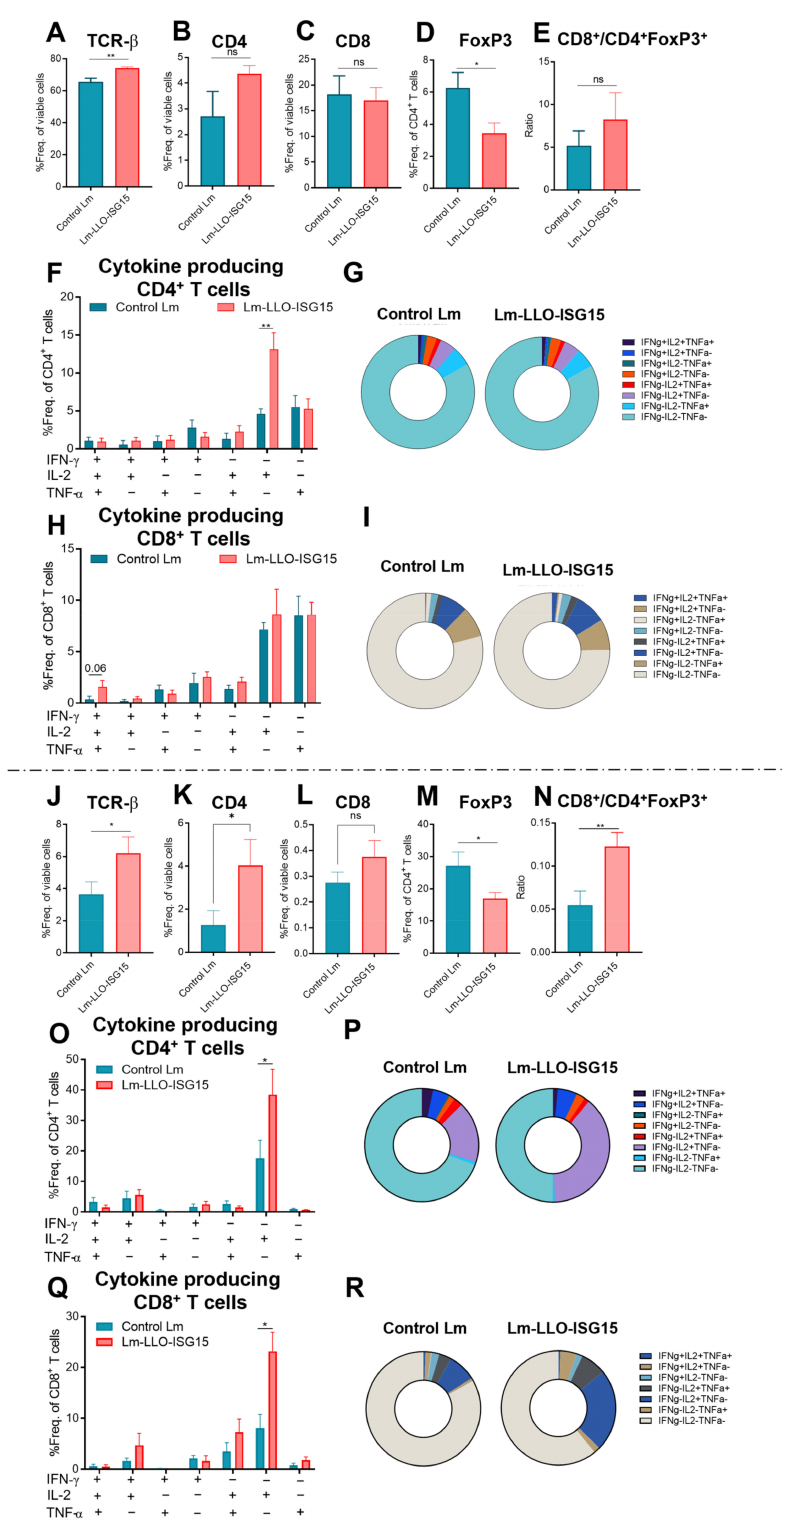
Figure 6. Induction of anti-tumor immune response with Lm-LLO-ISG15 in subcutaneous versus orthotopic CRC tumors. Single cells were prepared from tumors of experiment of Figure 5A and stained with different fluorochrome-conjugated antibodies as mentioned in Materials and